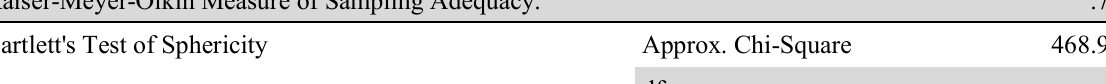
Test results of KMO and Bartlett’s Test Kaiser-Meyer-Olkin Measure of Sampling Adequacy. .785 Bartlett's Test of Sphericity